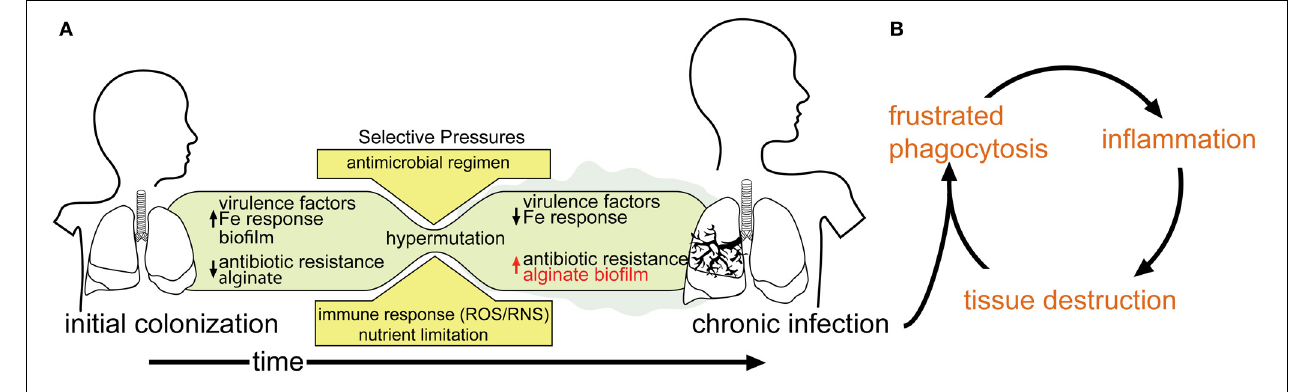
FIGURE 1 | Model of P. aeruginosa infection within a CF patient. (A) As infection proceeds to a chronic state, phenotypes associated with chronic infection (e.g., mucoidy) predominate, while acute virulence factors are